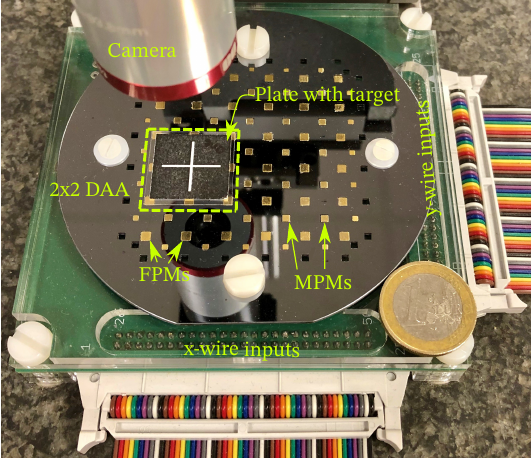
Figure 6. Picture of the real implementation and